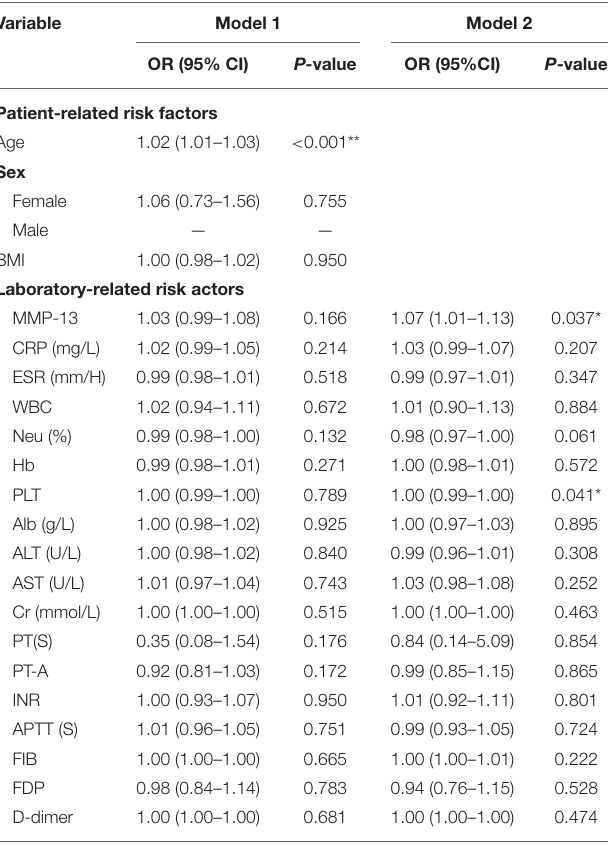
TABLE 2 | Predictive factors of knee osteoarthritis for model 1 (patient-and laboratory-related factors) and model 2 (laboratory-related factors).